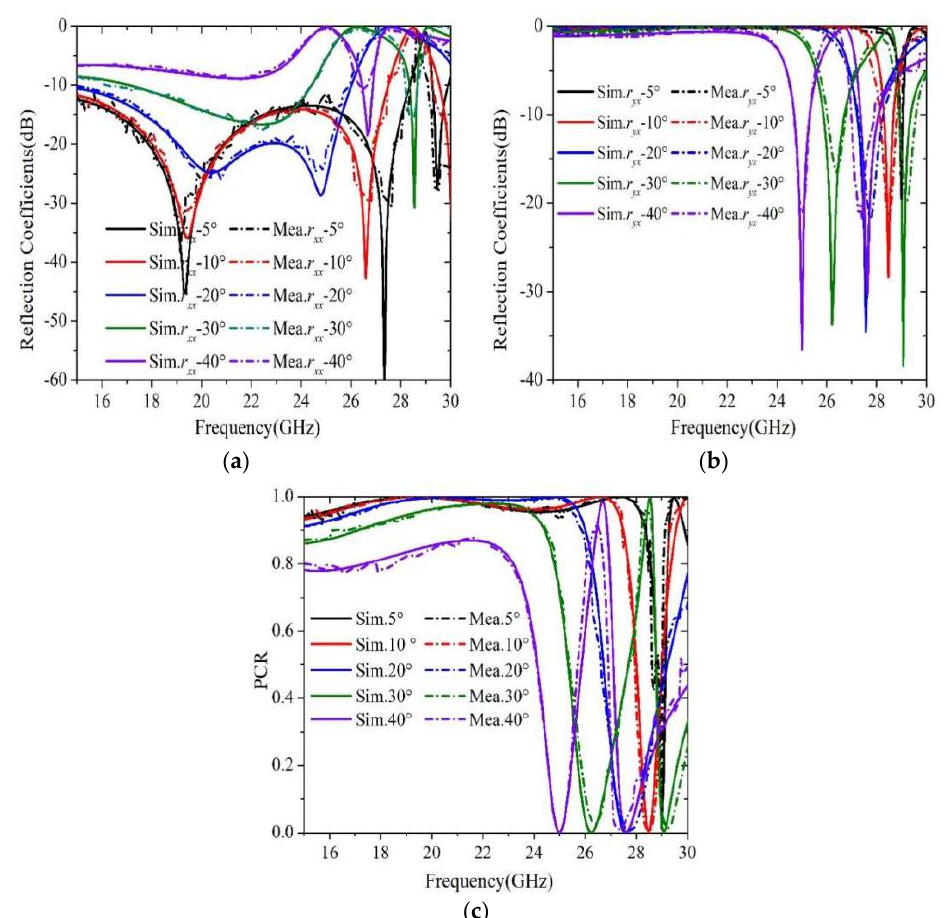
Figure 13. Simulated and measured results for different oblique incident angle. ( a ) Co-polarized reflection coefficient xx r ; ( b ) Cross-polarized reflection coefficient yx r ; ( c ) PCR.